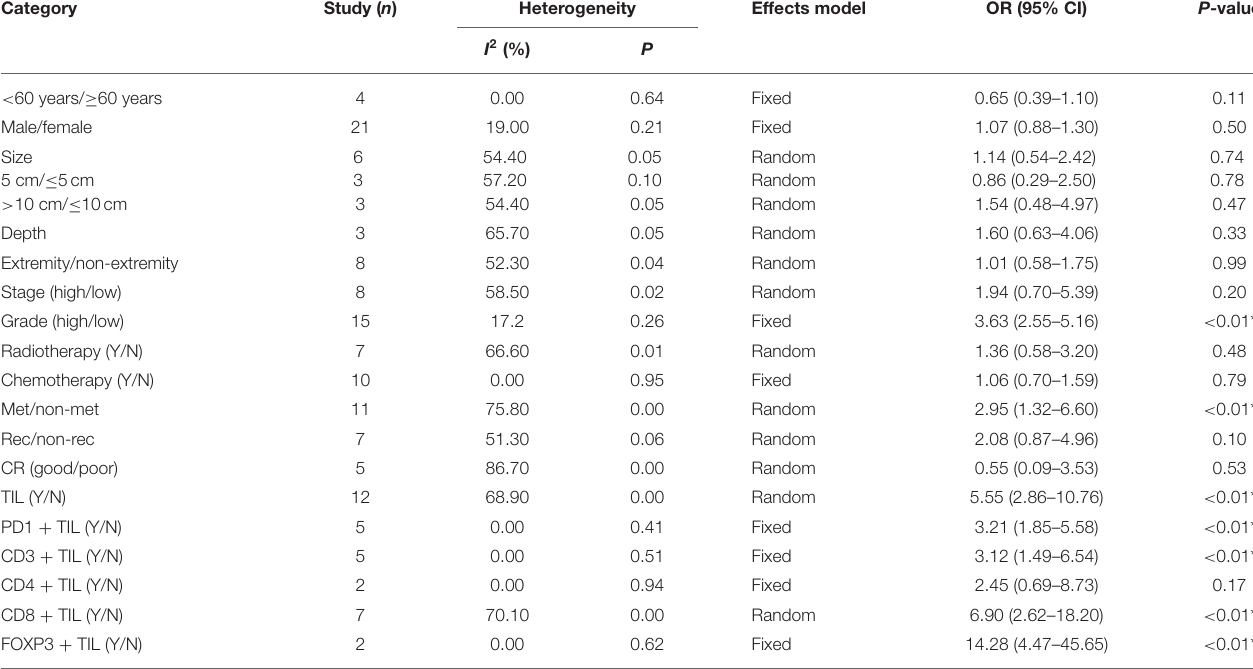
TABLE 3 | Summary of correlation between PD-L1 expression and clinicopathological outcomes.